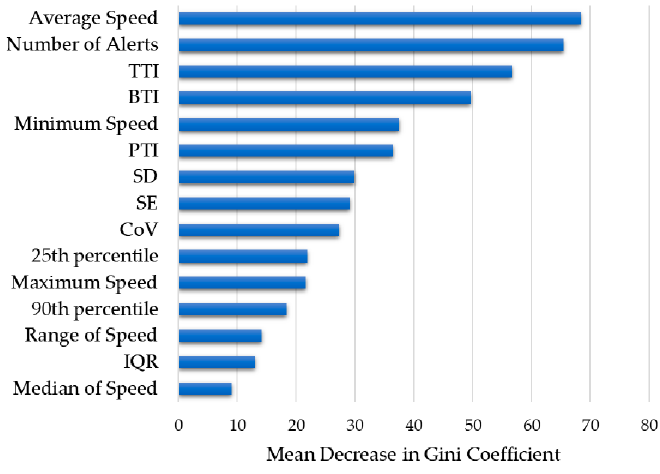
Figure 6. Variable importance